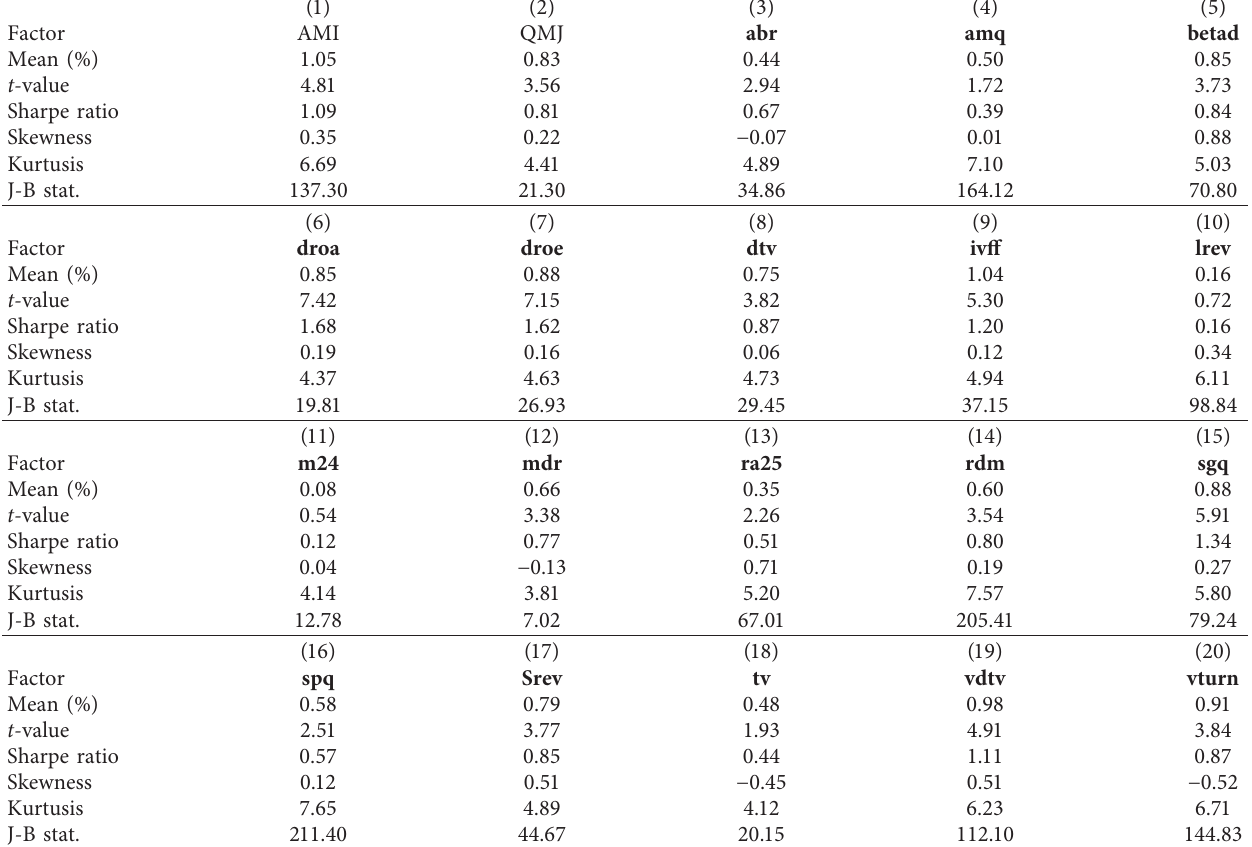
Table 7: Summary statistics of other factors. This table reports means, t -statistics, annualized Sharpe ratios, skewness, kurtosis, and Jarque–Bera statistics of factors which do not appear in previous models but are used in our double-selection LASSO approach. The sample period is from July 2000 to December 2019. AMI and QMJ denote the liquidity factor and Quality-Minus-Junk factor, respectively. Other factors are based on anomalies in Qiao [8] but reconstructed using bivariate 2 × 3 portfolios following Fama and French [18].